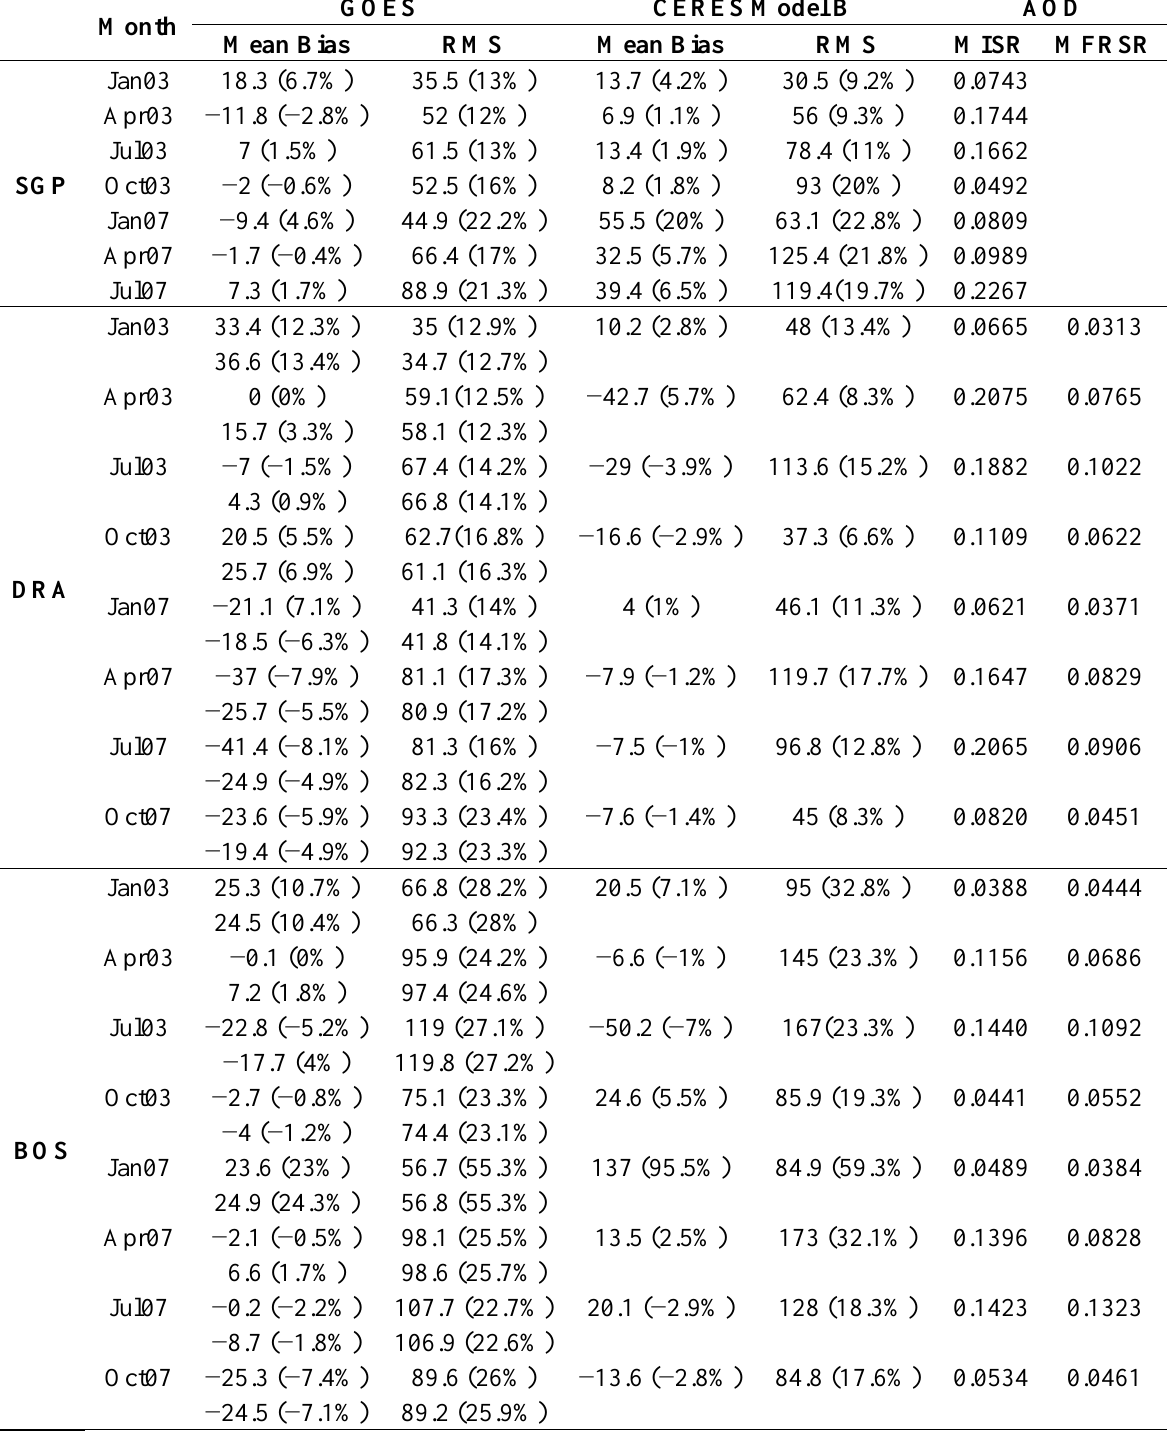
Table 3. Summary of error statistics for each station for each month for years 2003 and 2007. Results shown in the first line for each month use the multi-angle imaging spectroradiometer aerosol optical depths (MISR AOD) while those in the second line employs the on-site measurements of multifilter rotating shadowband radiometer (MFRSR) AOD’s. There were no on-site measurements for the Southern Great Plains (SGP) site. Mean bias and RMS are in W·m −2 , and the corresponding numbers in parenthesis are